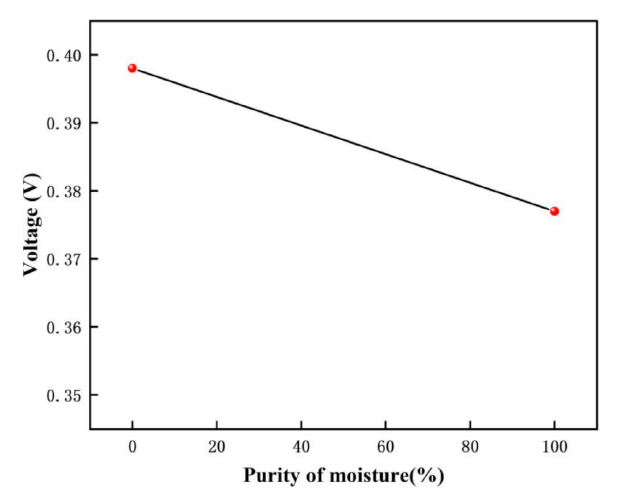
Figure 28. The voltage response graph for different purity moisture